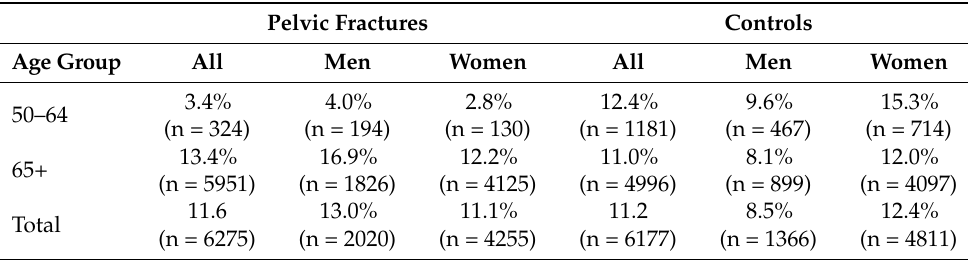
Table 2. One-year mortality after pelvic fracture and in matched fracture-free controls, stratified by age group and sex; n = number of deaths.